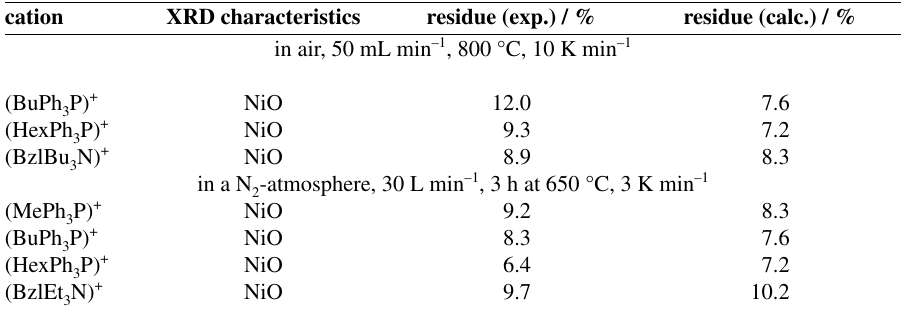
Table 5. Residues (experimental and calculated) of the products after thermal treatment during the TG/DTA-measurements and their XRD characteristics of the series of bis(1,2-dithiosquarato)nickela-